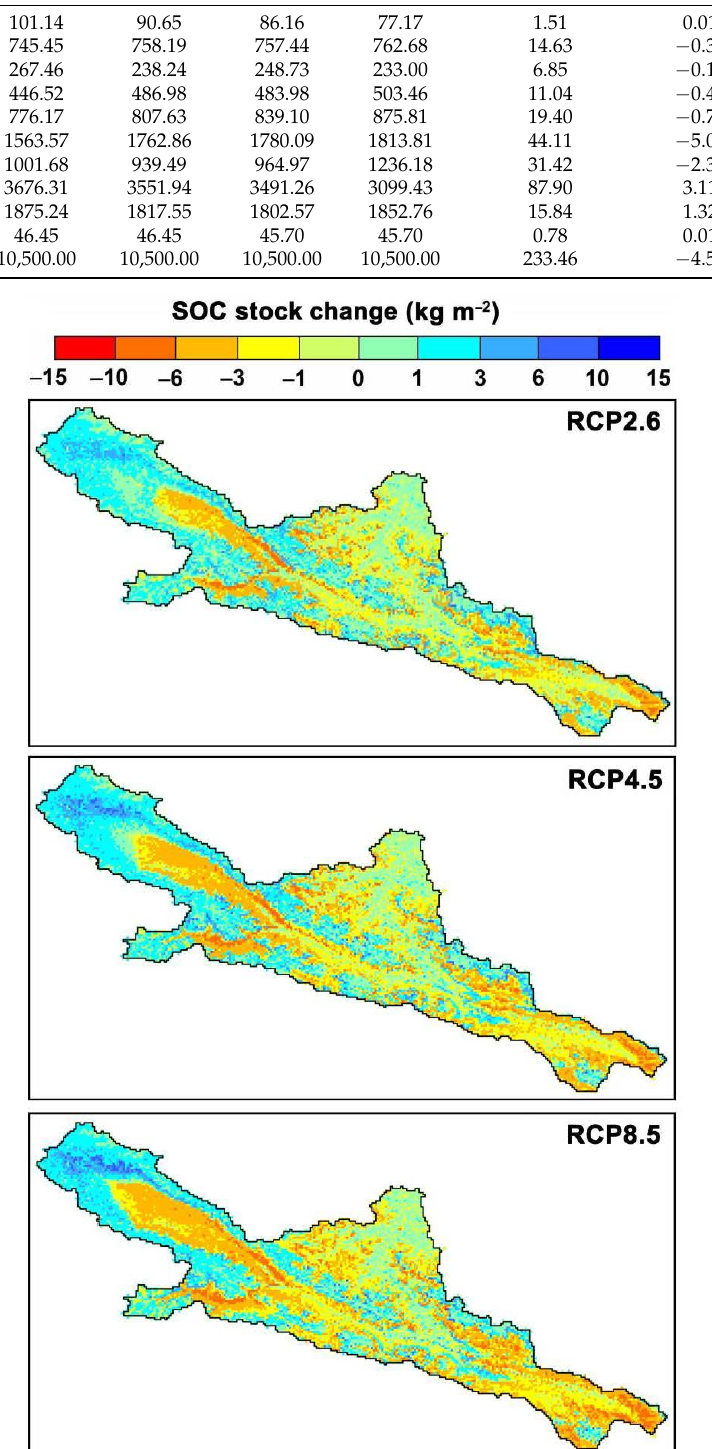
Figure 10. Spatial distribution of SOC stock changes from the 2000s to the 2050s under the RCP2.6, RCP4.5 and RCP8.5 scenarios.